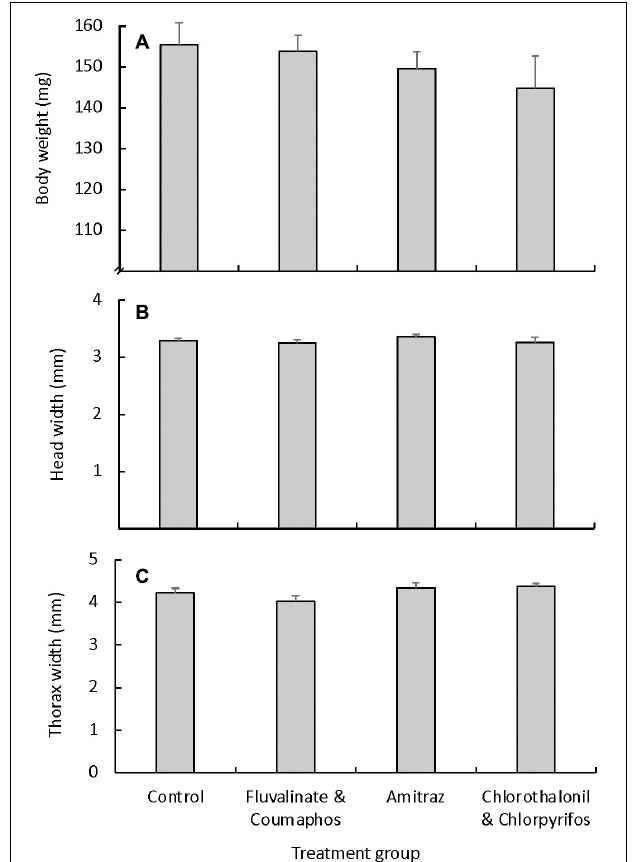
FIGURE 3 | External morphology measurements (mean ± S.E.M.) for virgin queens that were reared under different pesticide exposure conditions. Queens were grafted into plastic cups that were coated with pesticide-free molten wax (control group; n = 10), or wax containing either a combination of tau -fluvalinate and coumaphos ( n = 8), amitraz alone ( n = 6), or a combination of chlorothalonil and chlorpyrifos ( n = 6). We found no differences across treatment groups for either (A) body weight [ F ( 3 , 29 ) = 0.88, p = 0.46], (B) head width [ F ( 3 , 29 ) = 0.73, p = 0.54], or (C) thorax width [ F ( 3 , 29 ) = 2.17, p =